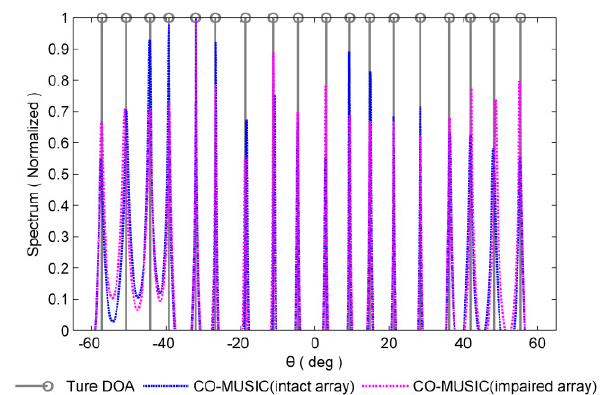
Figure 4. Normalized spectra of the coarray MUSIC (CO ‐ MUSIC) in redundant sensor failures scenario and intact array scenario are considered. The number of snapshots is 300 and SNR = 0 dB. For non ‐ redundant sensor failures, take the {5 ,20 ,24 } d d d position sensors failure in Figure 3